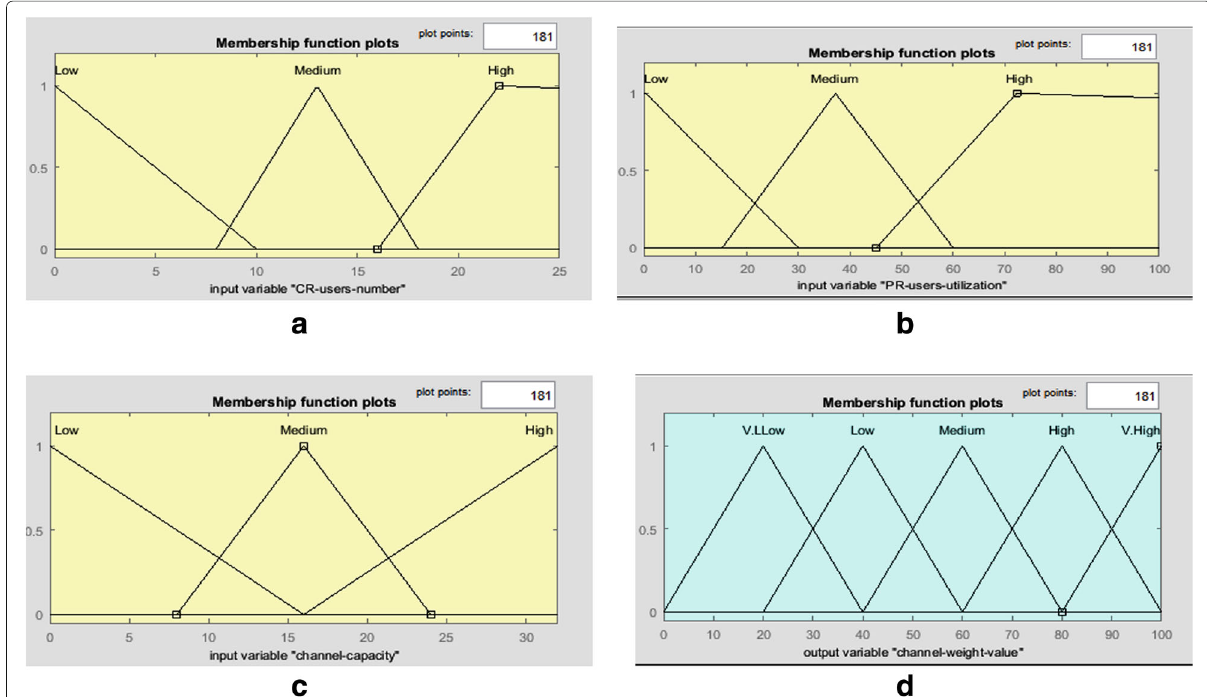
Fig. 5 Fuzzy membership sets of the input and output variables: a CR users’ number. b PUs’ utilization. c Channel capacity. d Fuzzy set for output weight value. The fuzzy membership sets of the input and output variables are